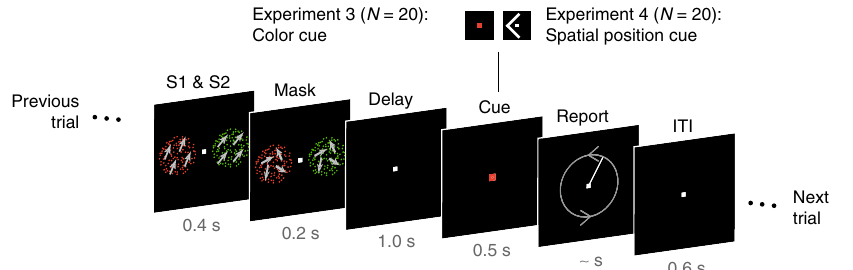
Fig. 4 Experimental paradigm of Experiments 3 and 4. In every trial, participants had to memorize motion directions (indicated here by gray arrows for illustration only) of two simultaneously presented dot fi elds (S1 and S2) and report one of them after a short delay by adjusting the orientation of a line (possible adjustment directions indicated here by gray arrows for illustration only). The to-be-reported target item was cued via color (Experiment 3) or via spatial position (Experiment